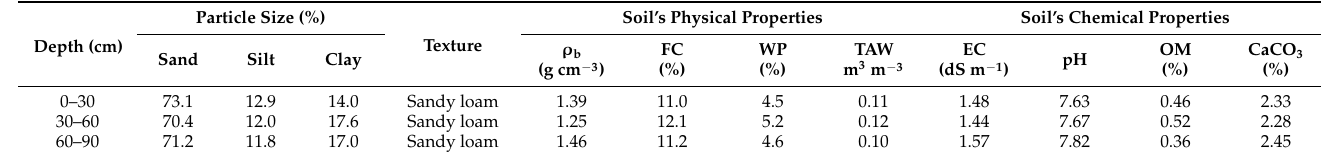
Table 1. Physical and chemical properties of the soil at the experimental